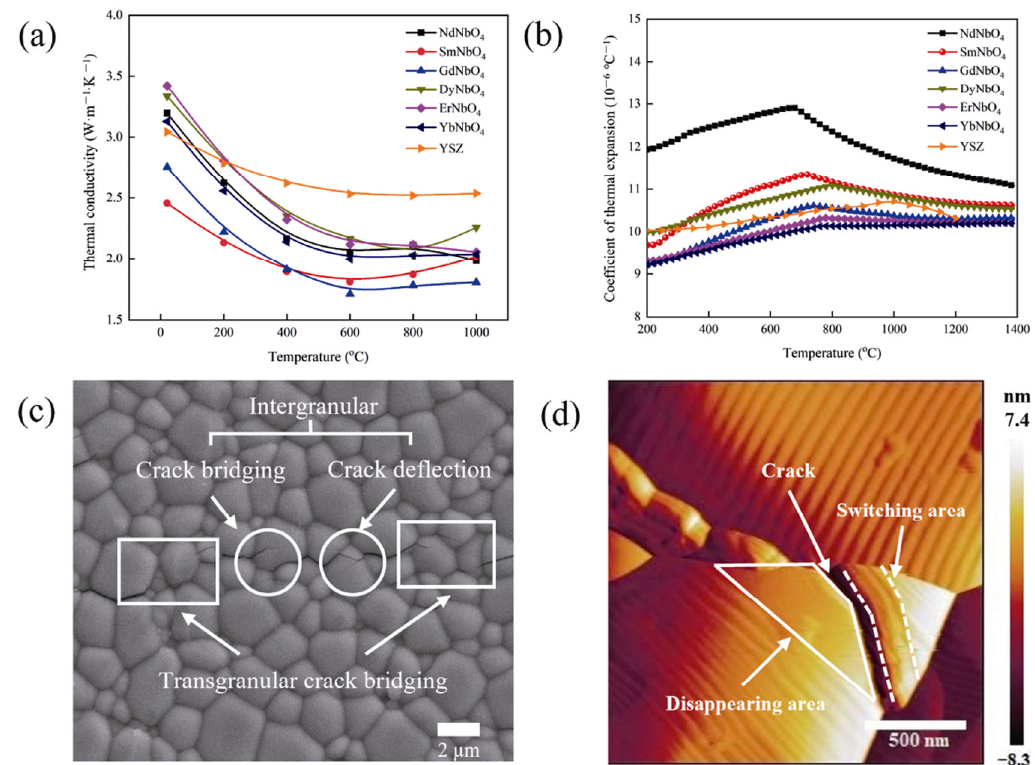
Fig. 11 Thermal properties, crack propagation, and domain state of RENbO 4 (RE = Nd, Sm, Gd, Dy, Er, Yb) ceramics: (a) thermal conductivity, (b) CTE, (c) crack propagation path, crack bridging, and deflection, and (d) ferroelastic domain state. Reproduced with permission from Ref. [77], © Acta Materialia Inc.